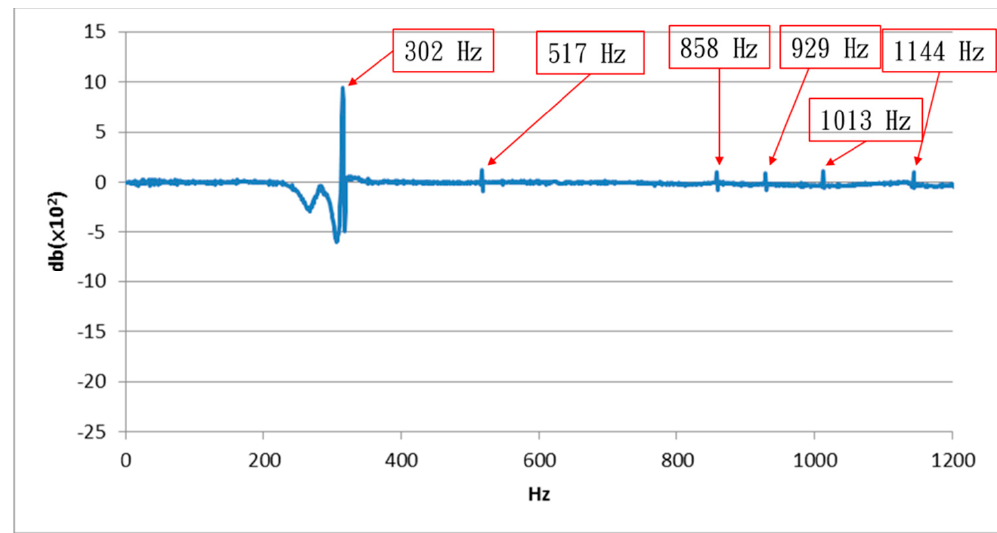
Figure 2. Vibration test apparatus.